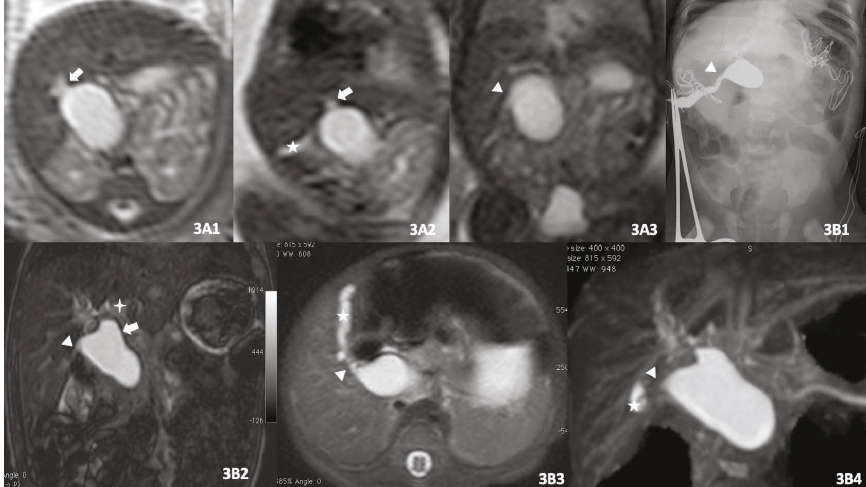
Figure 3: Case 8, G23 with CBA ∗ . A1–3: fetal MRI. Coronal (4A2–4A3) showed the cyst located in the hepatic hilar, parallel to the hepatoduodenal ligament, higher than the lower edge of the liver, and connected to the hepatic duct (white arrow) and gallbladder (white star)/duct (white triangle). Axial (4A1) showed the intrahepatic bile duct (white arrow) slight dilation. 16D postnatal MRCP ∗ (B2–B4) showed that the size of cysts did not change much. The hepatic ducts were slightly dilated (white arrow), the gallbladder (white star) was stiff and caterpillar-like. Coronary T2WI (B2) showed mild edema around the portal vein (white stars). Preoperative cholangiography (B1) confirmed cystic biliary atresia. ∗ CBA: cystic biliary atresia. ∗ MRCP: magnetic resonance cholangiopancreatography. ∗ T2WI: T2 weight